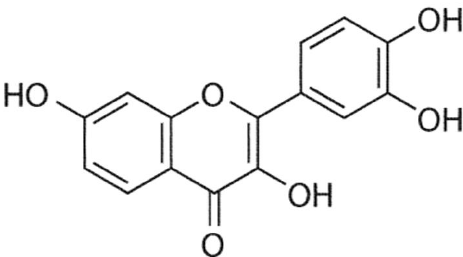
Figure 1. Chemical structure of fisetin.